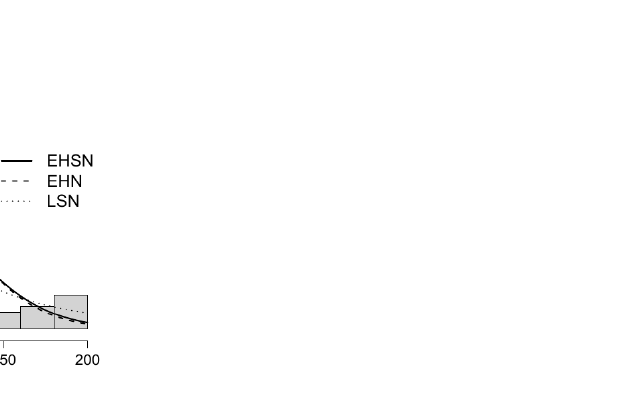
Figure 8. Histogram for volcano heights dataset and estimated models. EHSN (solid line), EHN (dashed line), LSN (dotted line).